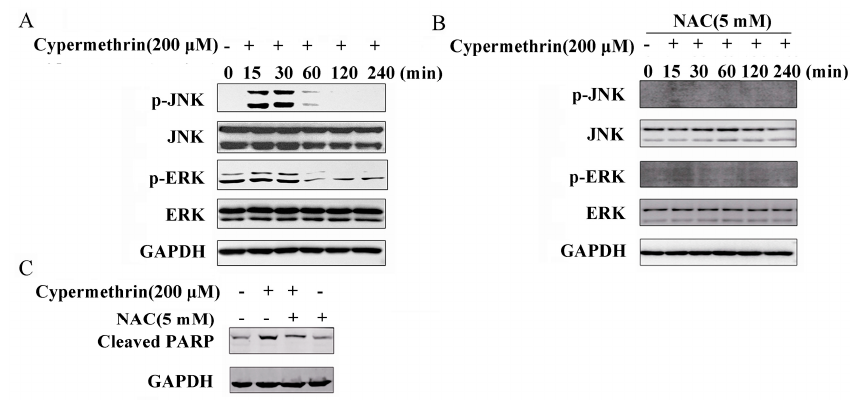
Figure 5. Cypermethrin induced activations of JNK and ERK MAPK signaling pathways. ( A ) RAW cells were treated with or without 200 μ M cypermethrin for 15–240 min, and JNK, ERK1/2 phosphorylation levels were examined by Western blot; ( B ) Furthermore, cells were pretreated with 5 mM NAC for 1 h and exposed to cypermethrin, and the phosphorylation levels of JNK, ERK1/2 were examined by Western blot. In addition, ( C ) Cells were treated for 48 h with DMSO, 200 μ M cypermethrin only, pretreated with 5 mM NAC before 200 μ M cypermethrin exposure, or 5 mM NAC only. The cleaved poly ADP-ribose polymerase (PARP) was examined by Western blot.